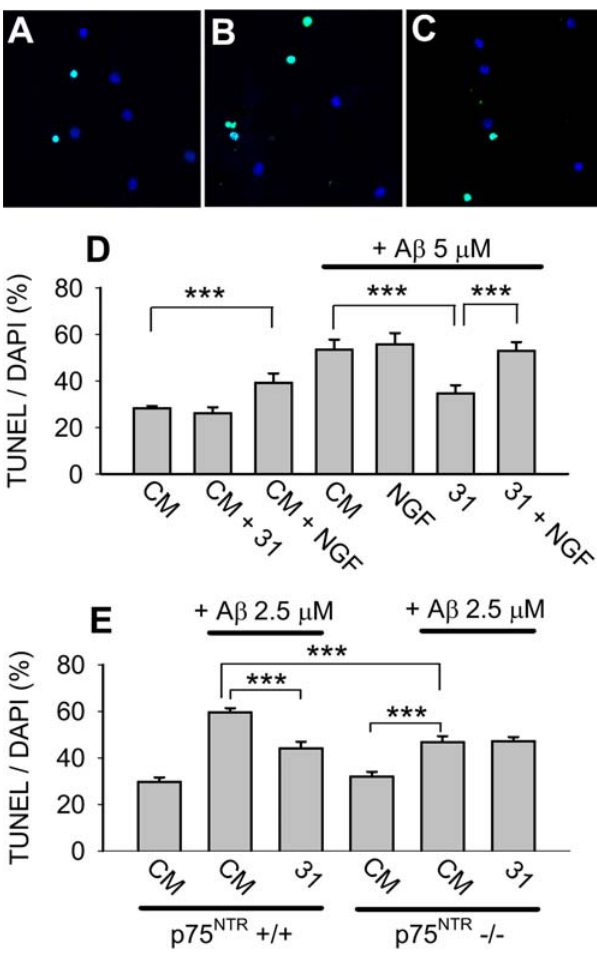
Figure 2. LM11A-31 inhibition of A b -induced toxicity is p75 NTR dependent. (A–C) 6–7 DIV hippocampal neurons were treated with: (A) CM alone; (B) 5 m M A b ; (C) 5 m M A b + 100 nM LM11A-31 for 72 hours and then stained with TUNEL/DAPI. Many neurons exposed to A b were TUNEL-positive (green), indicative of death; whereas the majority of neurons co-treated with A b and LM11A-31 were TUNEL- negative. (D) Quantitation of the percentage of TUNEL-positive neurons demonstrated that LM11A-31 alone had no effect on baseline death while NGF (100 ng/ml) was associated with a significant increase in death. A b caused an approximate 2.0-fold increase in death that was significantly inhibited by LM11A-31 but not NGF. In the presence of NGF, LM11A-31 failed to prevent A b -induced death (n=98–131 fields derived from a total of 6 separate experiments). (E) In 6–7 DIV hippocampal neuronalcultures derivedfromC57Bl/6 p75 NTR + / + and 2 / 2 mice, A b triggered a 2.0-fold increase in death in p75 NTR + / + cultures that was significantly inhibited by LM11A-31. In p75 NTR 2 / 2 cultures, A b triggered a significant 1.5-fold increase in death, a degree of increase significantly less than that found in + / + cultures. In p75 NTR 2 / 2 cultures, LM11A-31 demonstrated no protective effect (n=69–140 fields per condition, derived from a total of 4 separate p75 NTR 2 / 2 cultures and 6 separate p75 NTR + / + cultures).